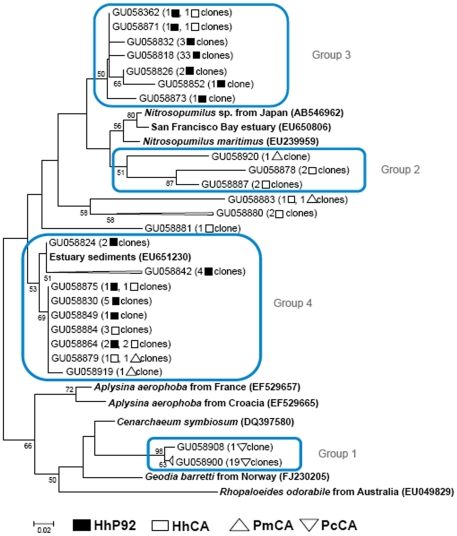
Phylogenetic relationships of sponge archaeal amoA genes.Unrooted neighbour-joining phylogenetic tree (▪) HhP92, (□) HhCA, (Δ) PmCA and (◊) PcCA. Hh, Hymeniacidon heliophila; Pm, Paraleucilla magna; Pc, Petromica citrina; CA, Cagarras Archipelago; P92, inner bay site.